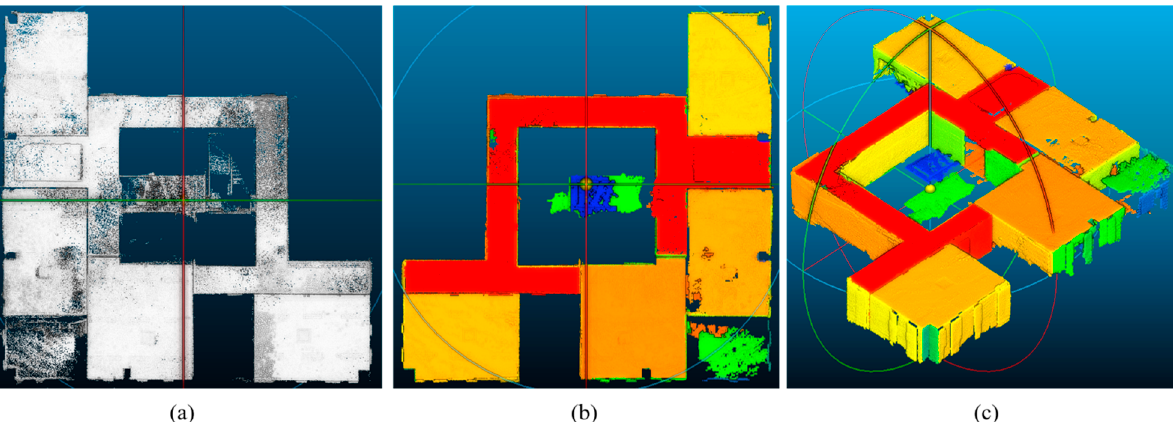
Figure 13. Implementation results of Dataset #2. ( a ) Raw PCD; ( b ) Top view of detected building components; ( c ) Front isometric view of detected building components.